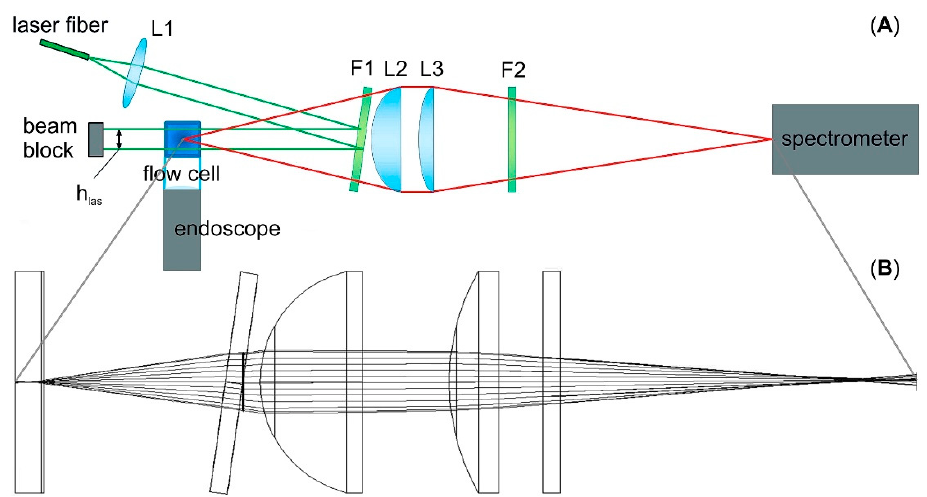
Figure 1. Schematic of the optical setup with orientation of the flow cell perpendicular to the image plane ( A ) and beam path from the center of the flow cell to the entrance slit of the spectrometer ( B ). For detecting single particles in a streaming medium, the optimal integration time of the spectrometer T opt depends on the particle speed v flow with which the particles pass through the laser beam, generating an e ff ective excitation time T e ff for the Raman spectrum determined by the cross-sectional area of the flow cell A cell , the height of the laser beam h las , and the pump rate Q pump :